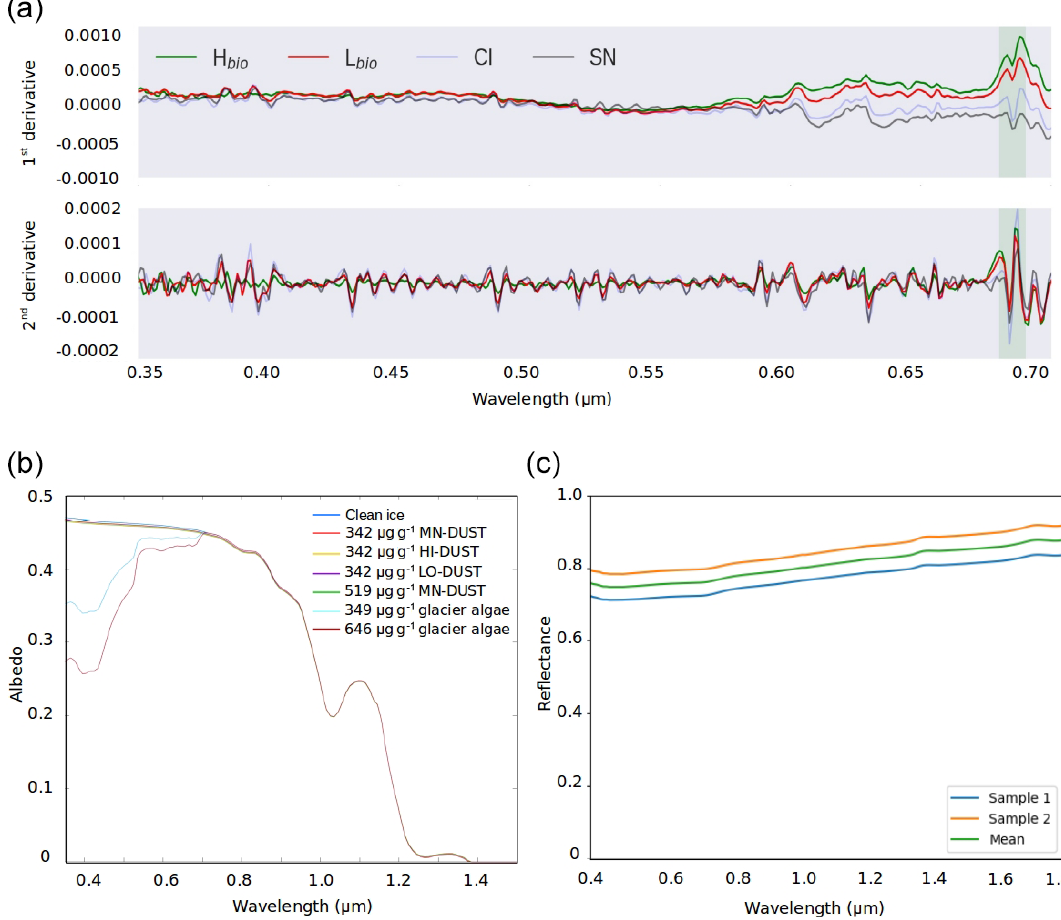
Figure 5. (a) The first and second derivative spectra for each surface class. (b) BioSNICAR-GO modelled spectral albedo for clean ice (blue) and ice with each of the simulated local dusts and algae in their measured mass mixing ratios in the upper 1mm. (c) Reflectance for an optically thick layer of two samples of the local mineral dust. Table 2. Albedo change relative to clean ice caused by the addition of each LAP to the upper 1mm of ice in a range of mass mixing ratios from 10 to 1000µg LAP g ice − 1